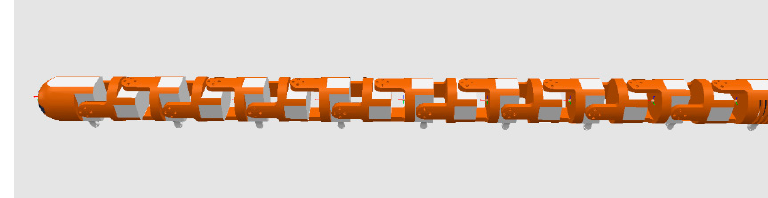
Figure 1. Simulation model of snake robot.